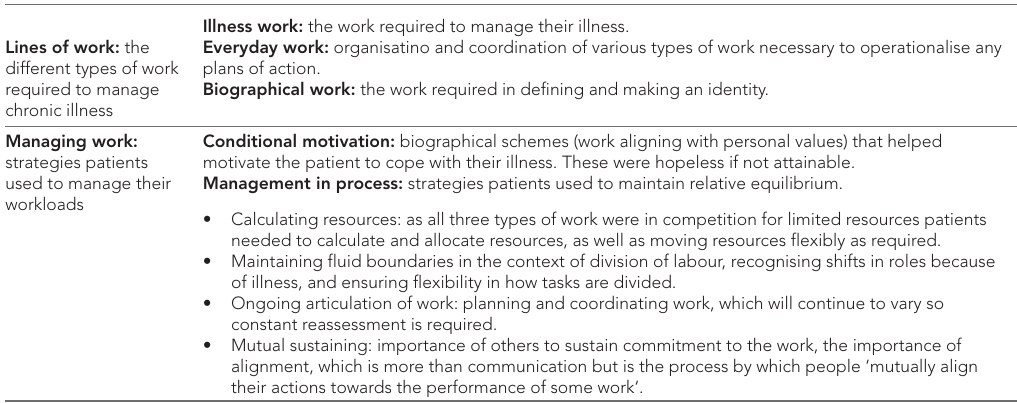
Table 1 Summary of Corbin and Strauss’s Managing chronic illness at home: three lines of work 17